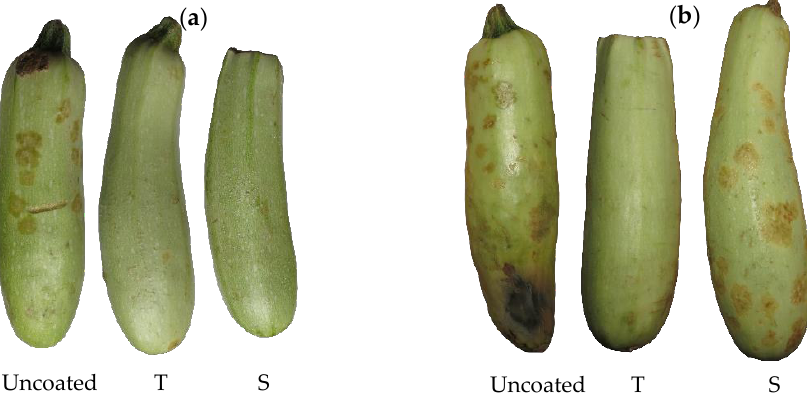
Figure 8. Zucchinis after 12 ( a ) and 42 ( b ) days of storage.